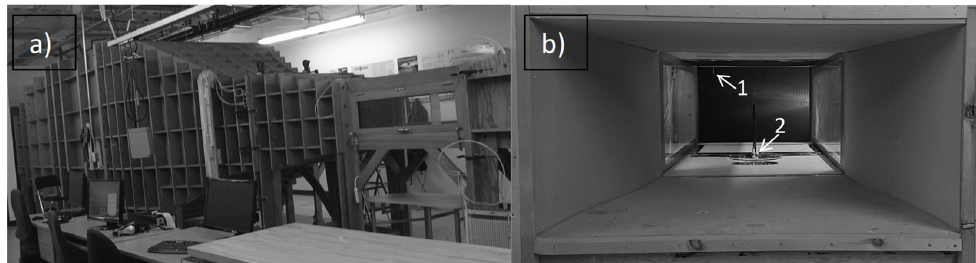
Figure 1. ( a ) The Price–Païdoussis Open Return Subsonic Wind Tunnel. ( b ) Pitot tube location (1) and aerodynamic scale location (2). aerodynamic scale location